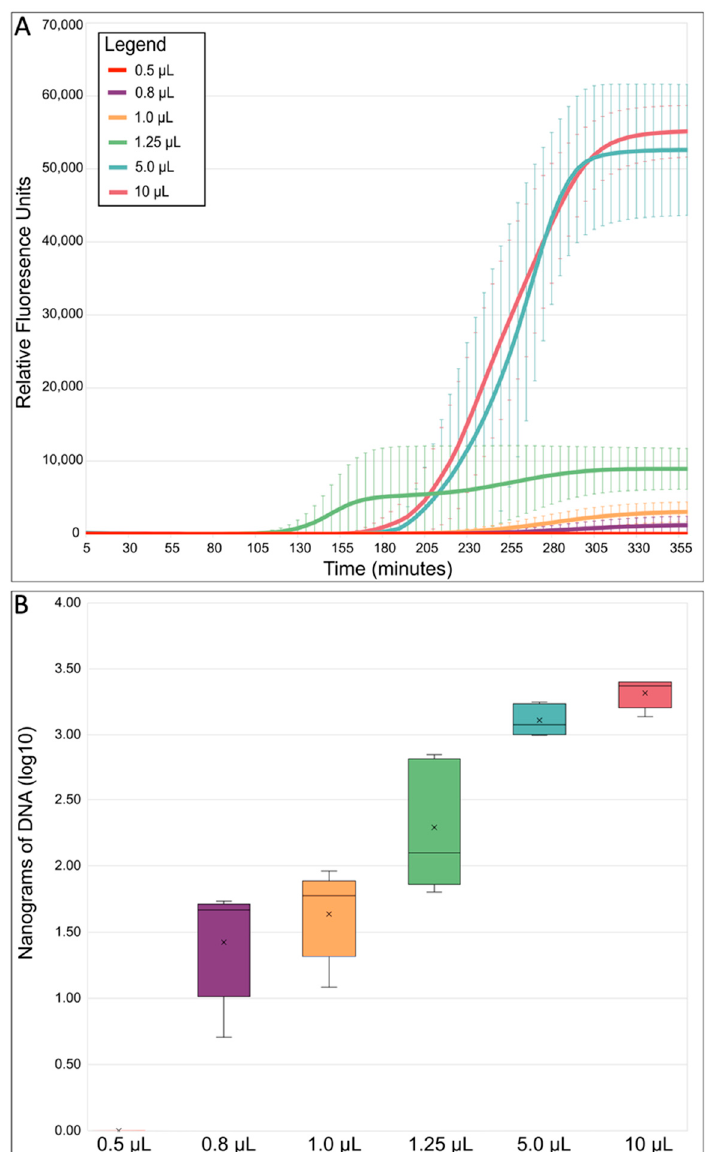
Figure 3. MDA reaction statistics overview. ( A ) Average MDA reaction kinetics by reaction size. Standard error bars represent the standard deviation calculated using all five replicates from each reaction volume. ( B ) Average MDA amplification yield by reaction size. Relative fluorescence units (RFU) refer to the fluorescent signal of SYTO ™ ‐ 13 measured with a real ‐ time thermo ‐ cycler. SYTO ™ ‐ 13 is used to monitor the progression of MDA because it binds to double ‐ stranded DNA as it is amplified. The boxes’ middle line represents the median, and the x represents the mean. Five replicates were used for calculation.